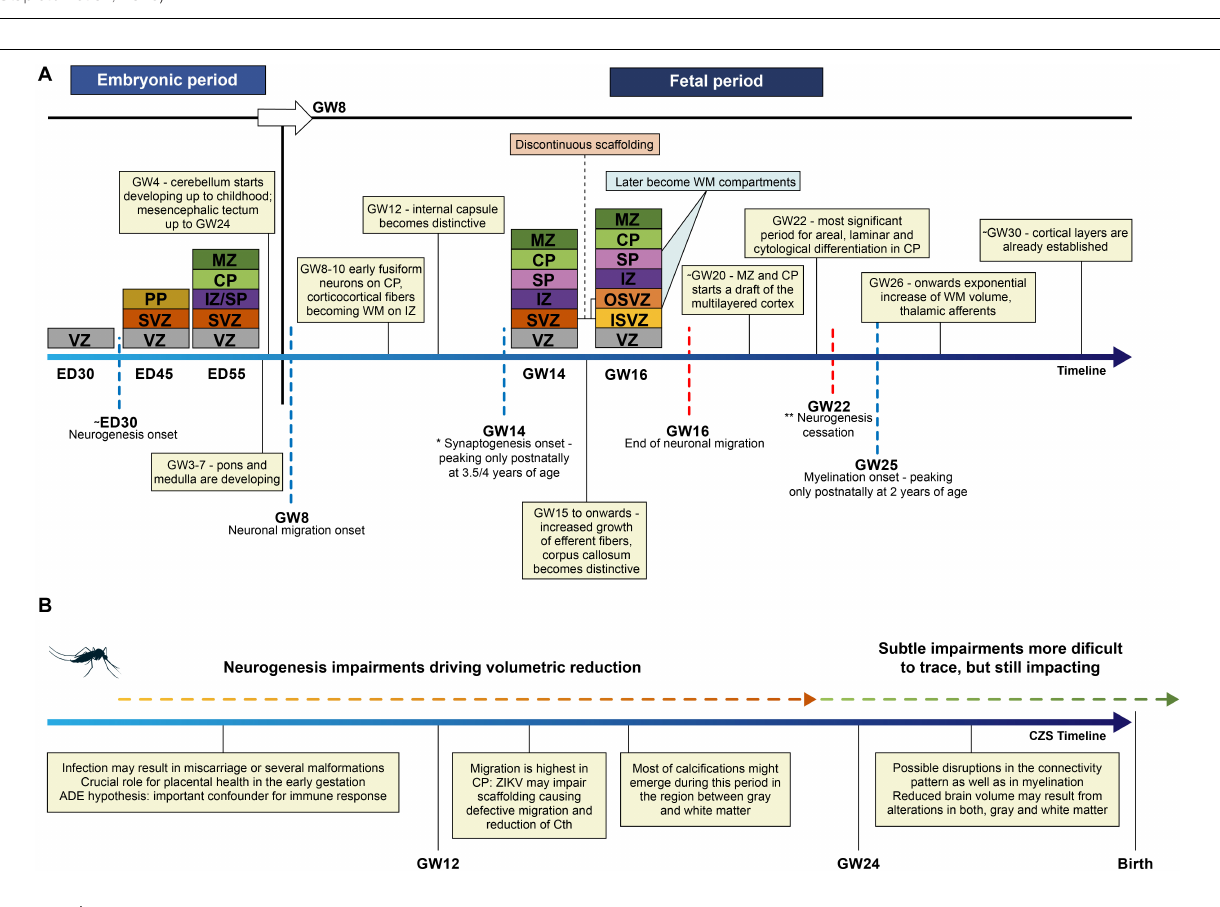
FIGURE 3 | (A) Schematic representation of the embryonic layers in the typical developing neuroepithelium is depicted in colors, proportional intervals in the timeline were not respected. ED – embryonic days; GW – gestation week; Cth – cortical thickness; VZ – ventricular zone, PP – preplate, SVZ – subventricular zone, IZ – intermediate zone, SP – subplate, CP – cortical plate, MZ – marginal zone, OSVZ – outer subventricular zone, ISVZ – inner subventricular zone. Discontinuous scaffolding is a singular pattern of migration that splits SVZ into two discontinuous layers; OSVZ is supposed to drive the tangential or radial expansion of the human brain through the outer radial glia cells. *Considering the maturation of the membranes; ** referring to the neurogenesis waves in the whole brain, though some regions, i.e., hippocampus keeps active processes of neurogenesis in the adult life. (B) Some key events that may occur are represented in the timeline of prenatal neurodevelopment after ZIKV infection. These events depend not only on the period of the infection but also on the many covariates. Therefore, the severity of findings in CZS is highly